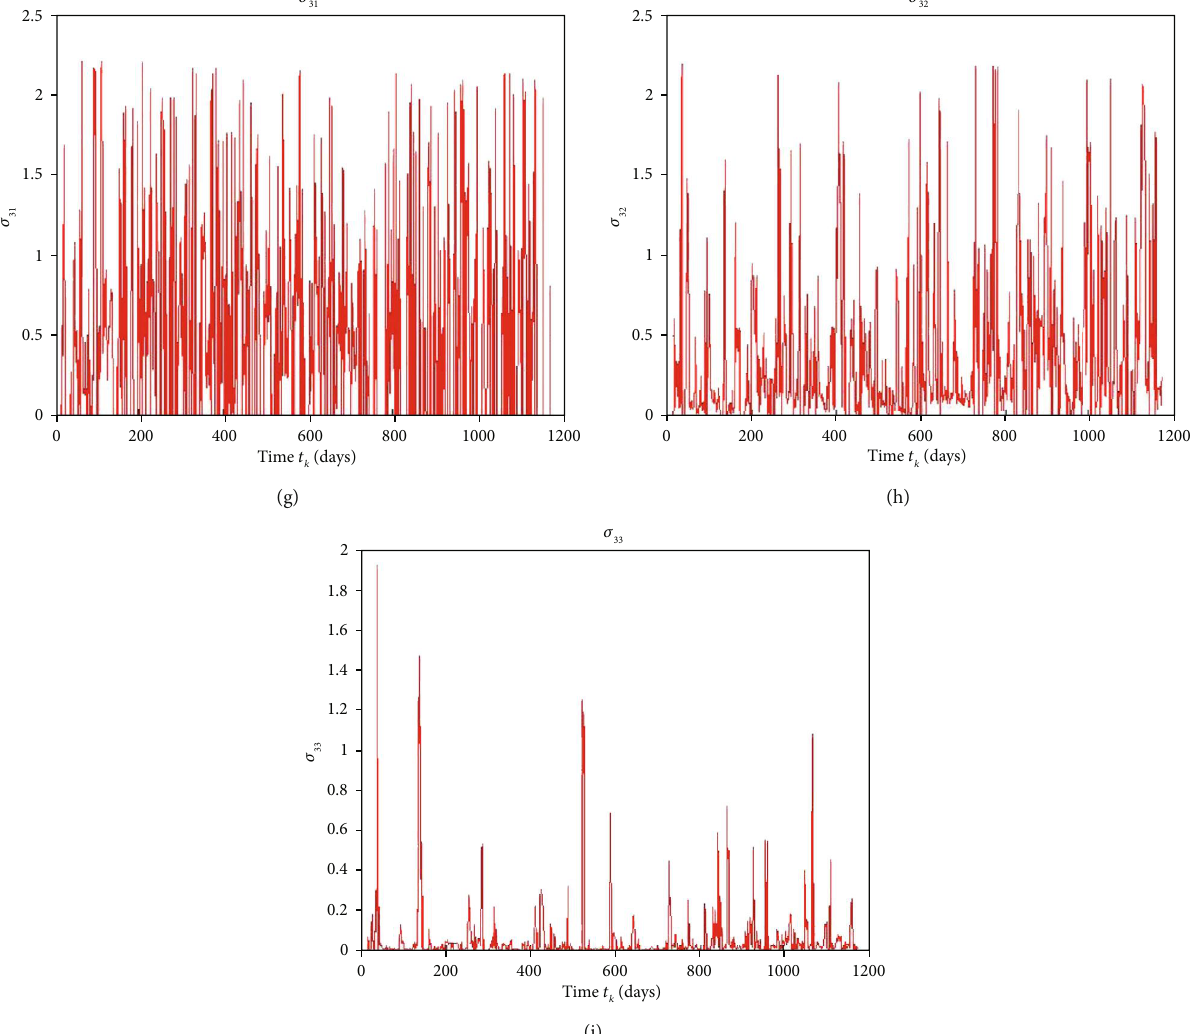
ð ̂ m , k Þ , σ 1,1 k